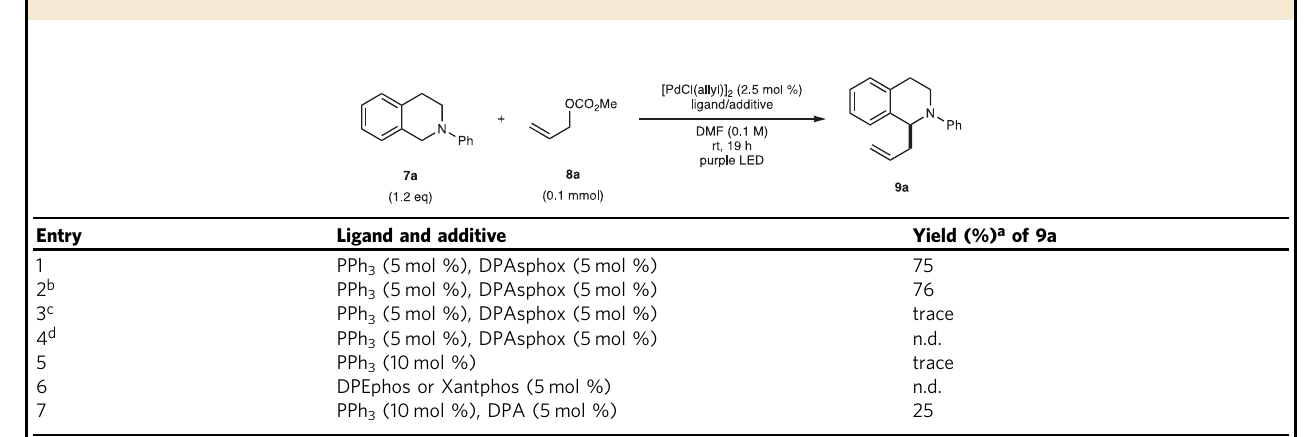
Table 1 Establishment of the reaction